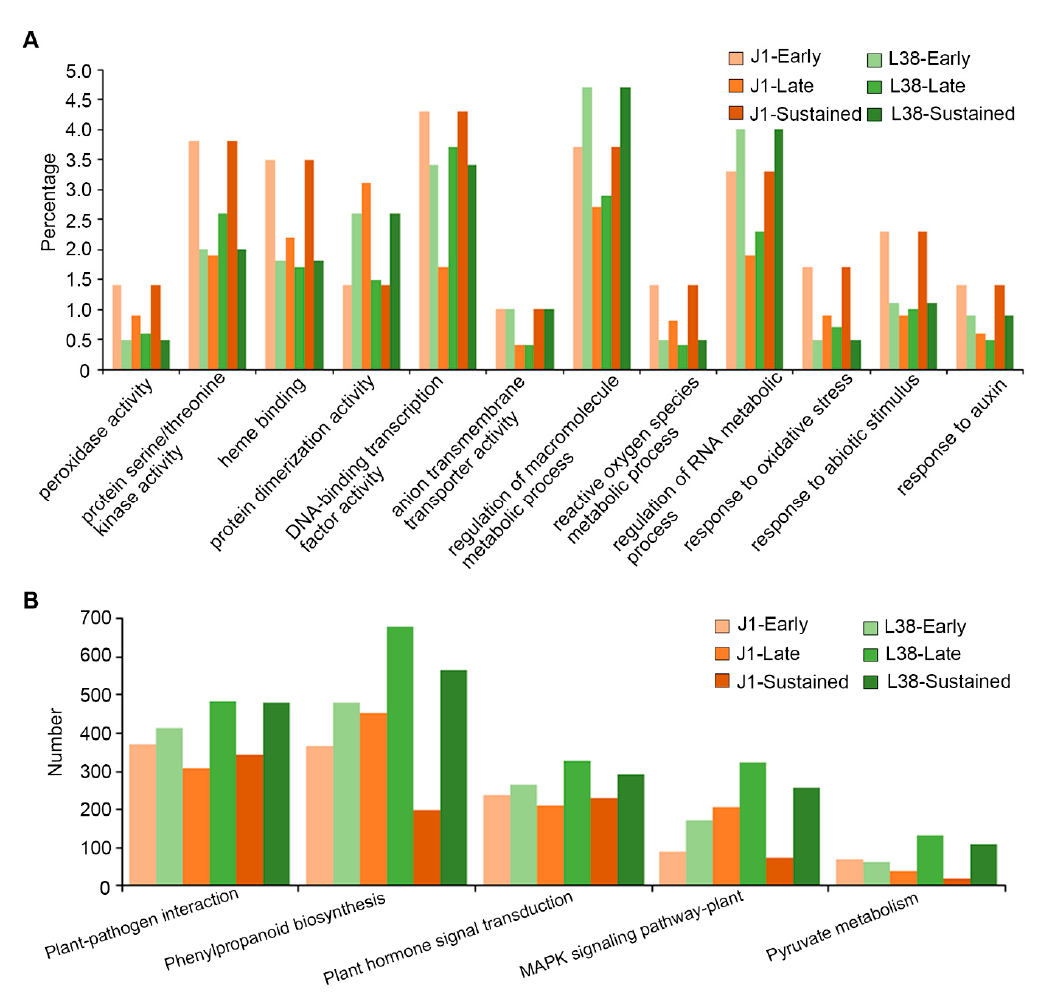
Figure 3. Gene ontology (GO) enrichment and KEGG pathway analysis of DEGs in J1 and L38 during Verticillium dahliae inoculation. ( A ) GO analysis for these DEGs classified in six groups, with p -value < 0.05. ( B ) Pathways related to resistance were identified by KEGG analysis with p -value < 0.05.